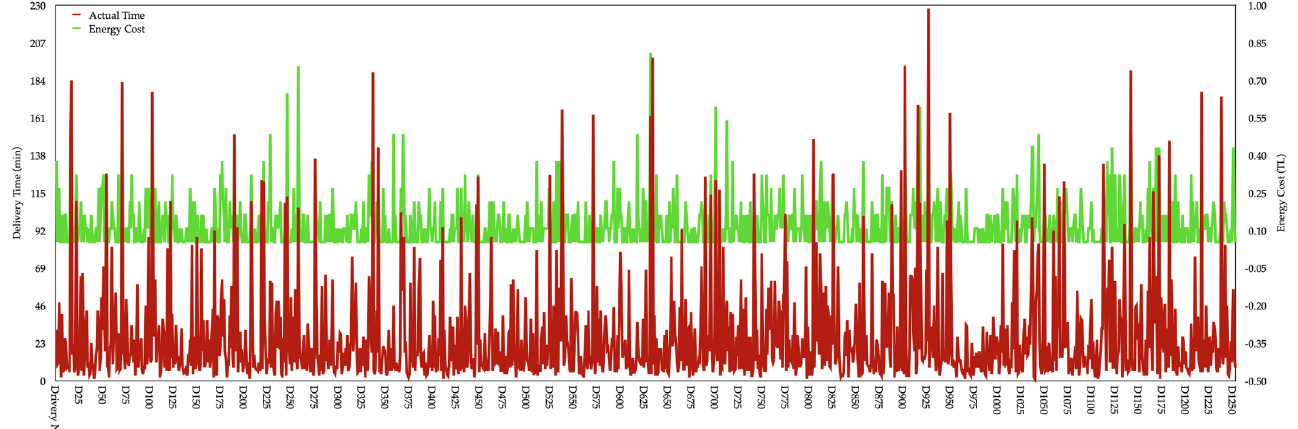
Figure 9. The comparison between delivery time and delivery energy cost based on the testing data.